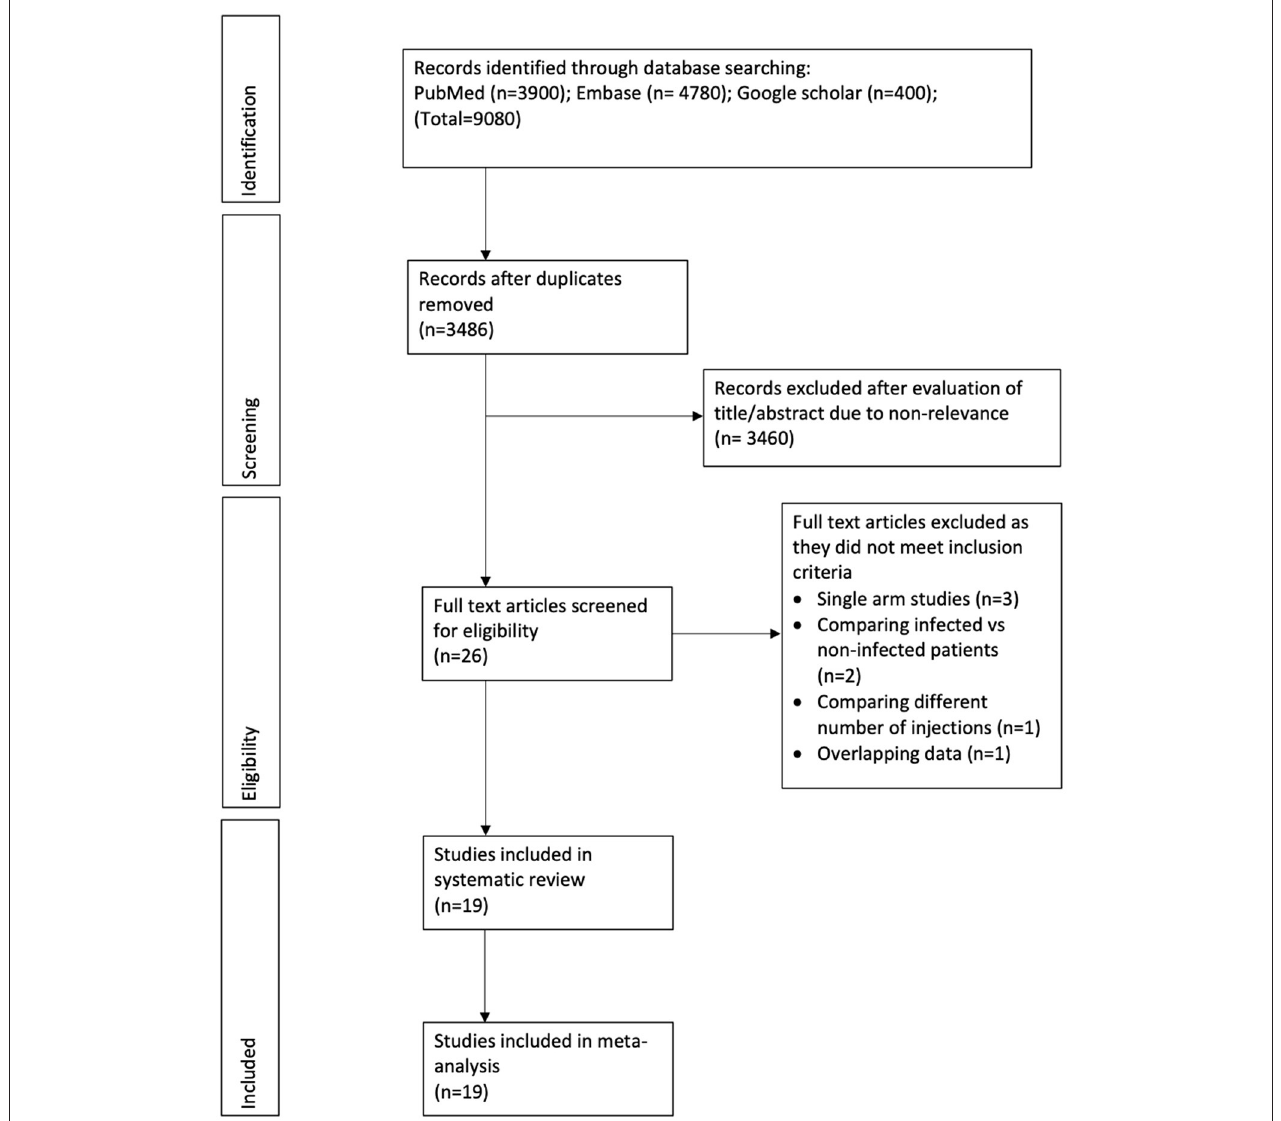
FIGURE 1 | Study flow